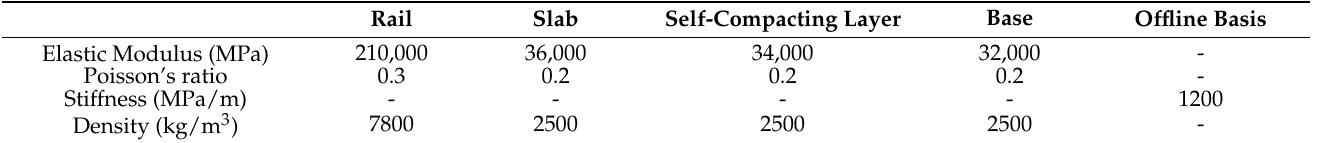
Table 2. Main structure parameters.